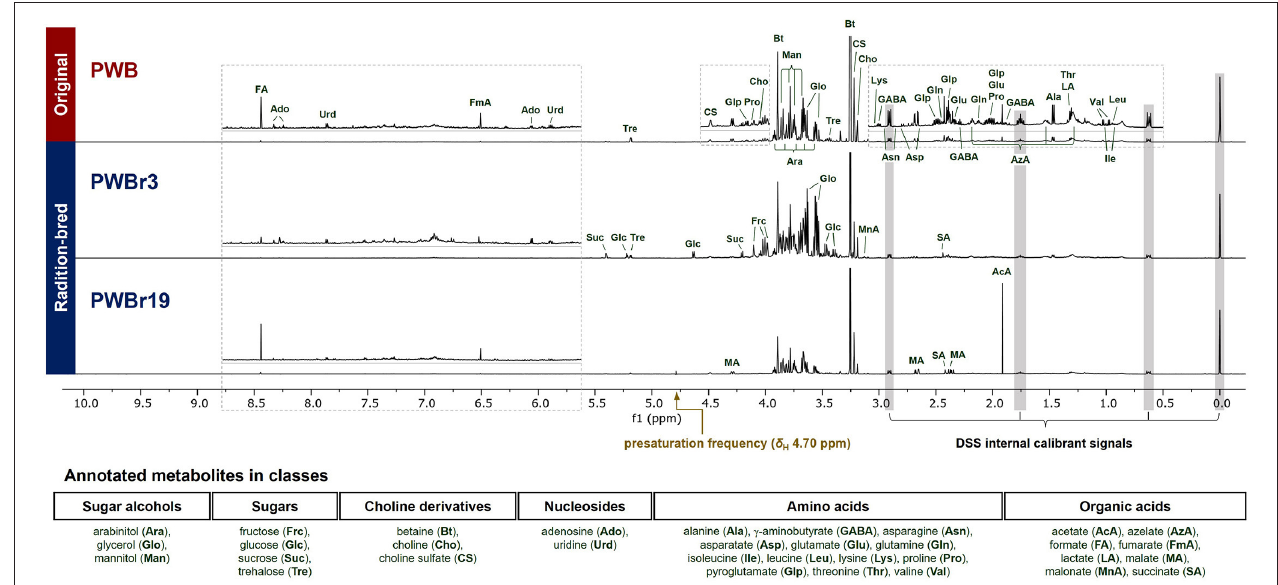
FIGURE 1 | Annotated 1 H NMR spectra (600 MHz, D 2 O) of three representative purple wheat bran samples (top to bottom, PWB, original; PWBr3 and 19, radiation-bred). The “1D NOESY presat” pulse sequence was used for data acquisition with δ H 4.70 ppm of a presaturation frequency. PWB, purple wheat bran; PWBr, radiation-bred mutant of purple wheat